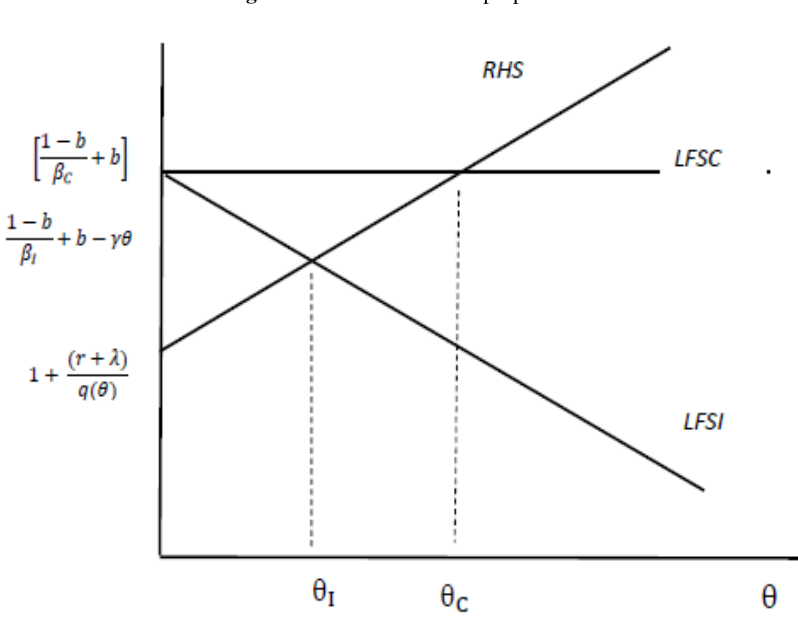
Figure 3: Demonstration of proposition